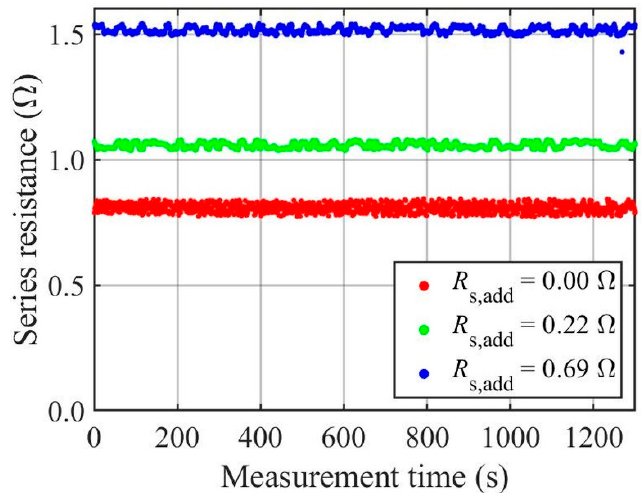
Figure 20. Fitted series resistance values using additional series resistors as a function of measurement time when using the cutting limit of 50% based on MPP power for I – U curves.